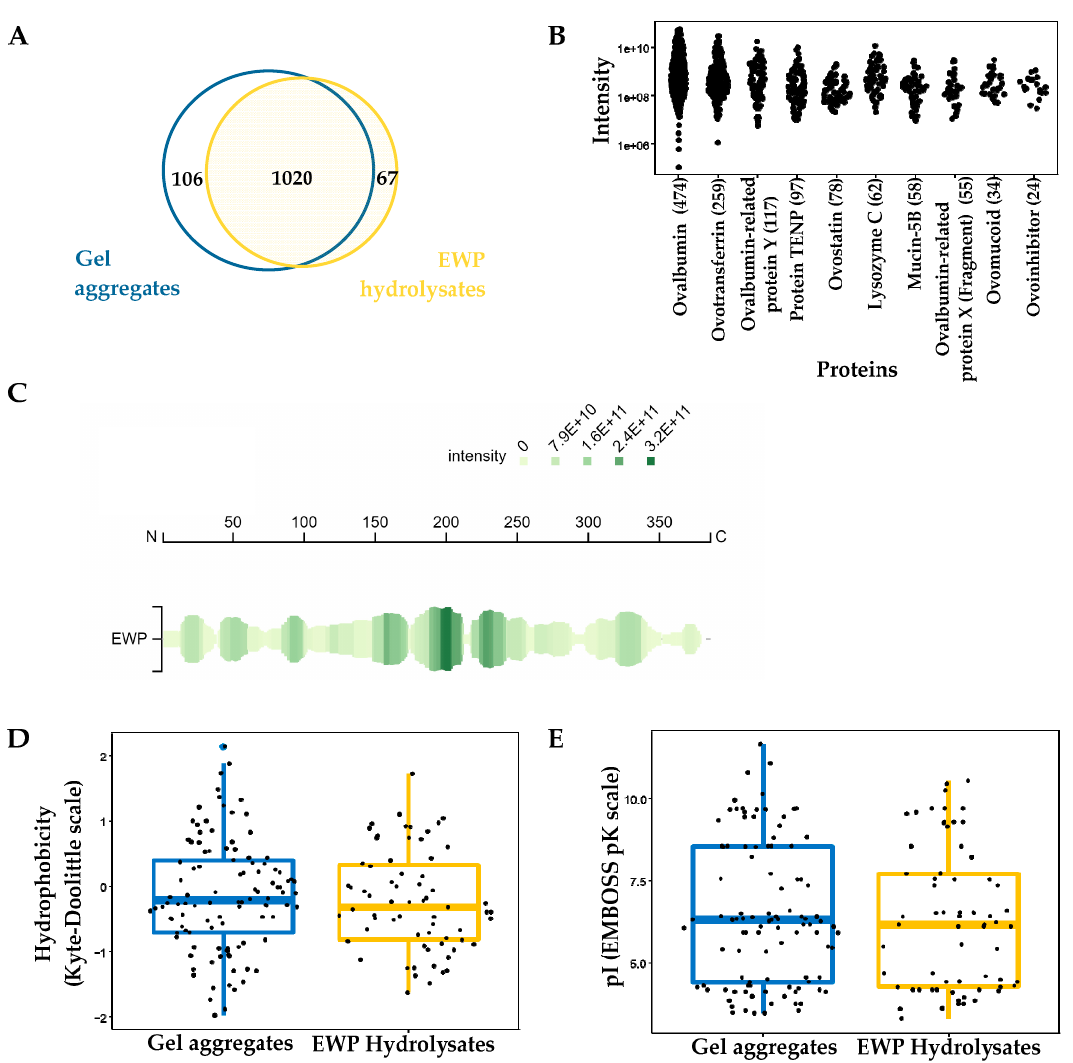
Figure 2. ( A ) Number of peptides identified in both samples and ( B ) the protein origin of the peptides. ( C ) Coverage of the ovalbumin peptides. ( D ) Distribution of hydrophobicity scores and ( E ) the isoelectric points (pI) of peptides from the gel aggregate and EWP hydrolysate samples.